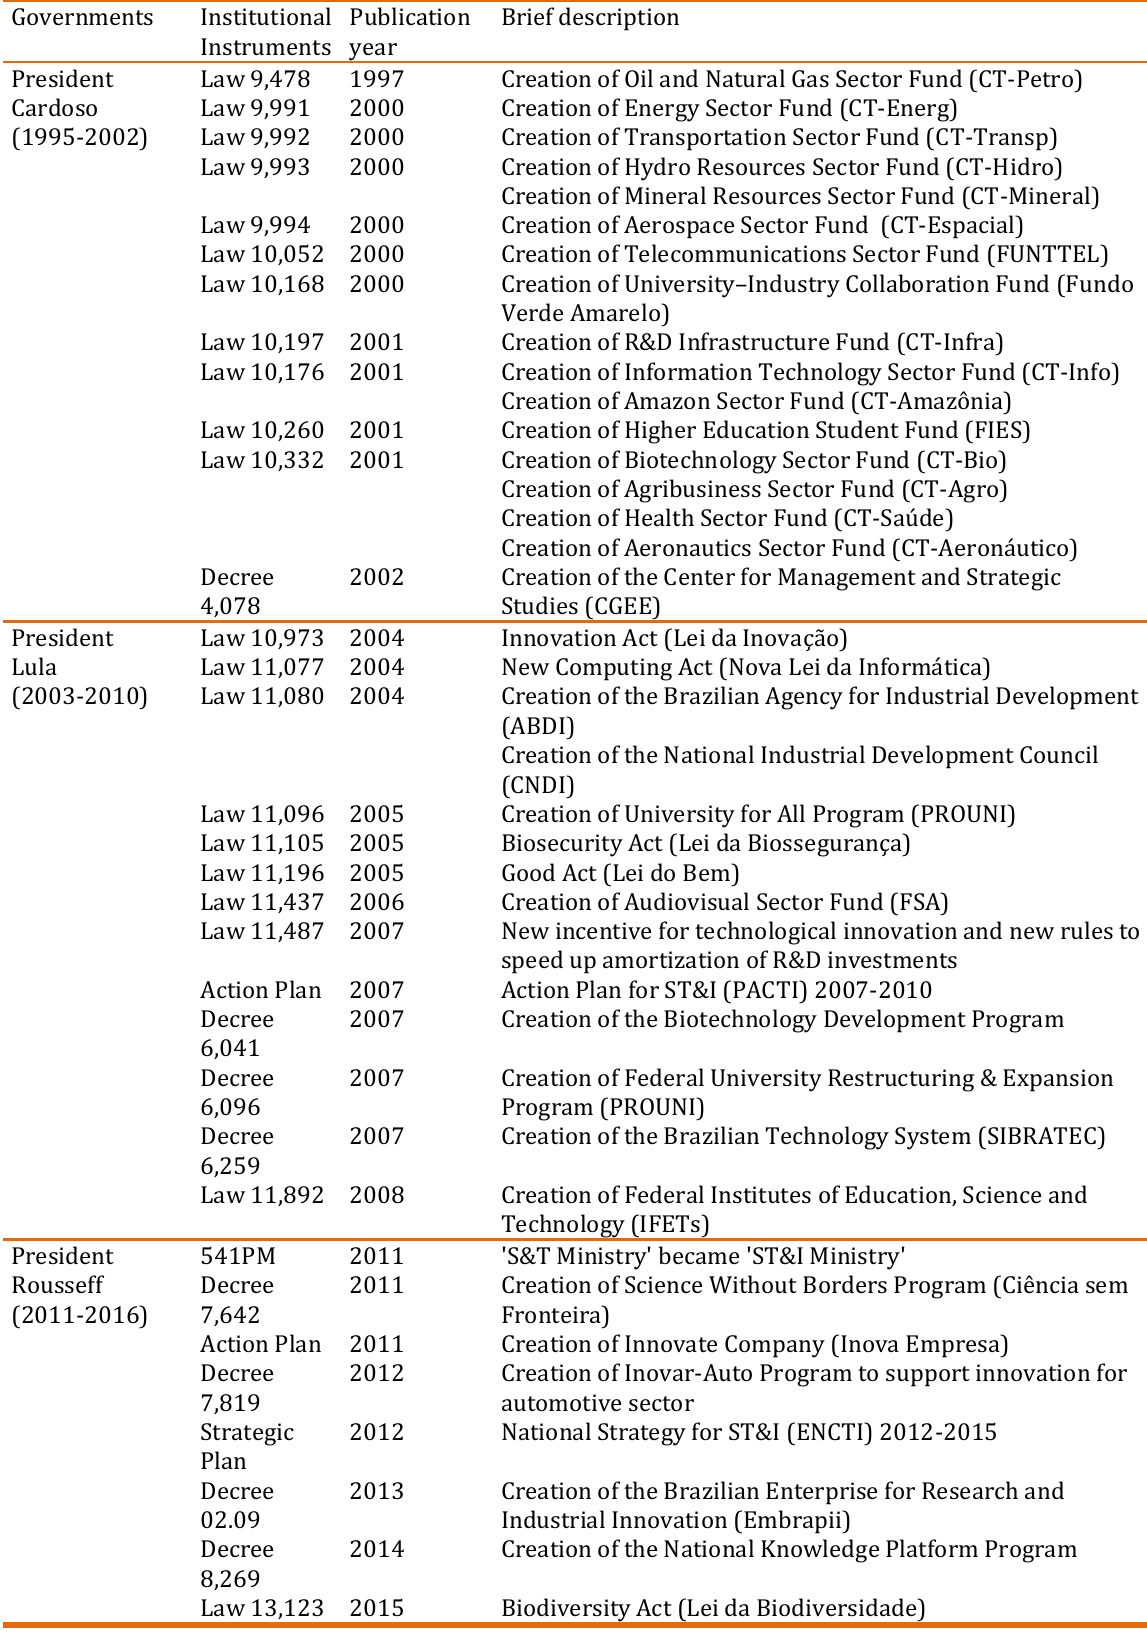
Table 03 . Milestones in ST&I institutional advancements in Brazil, from the mid-1990s